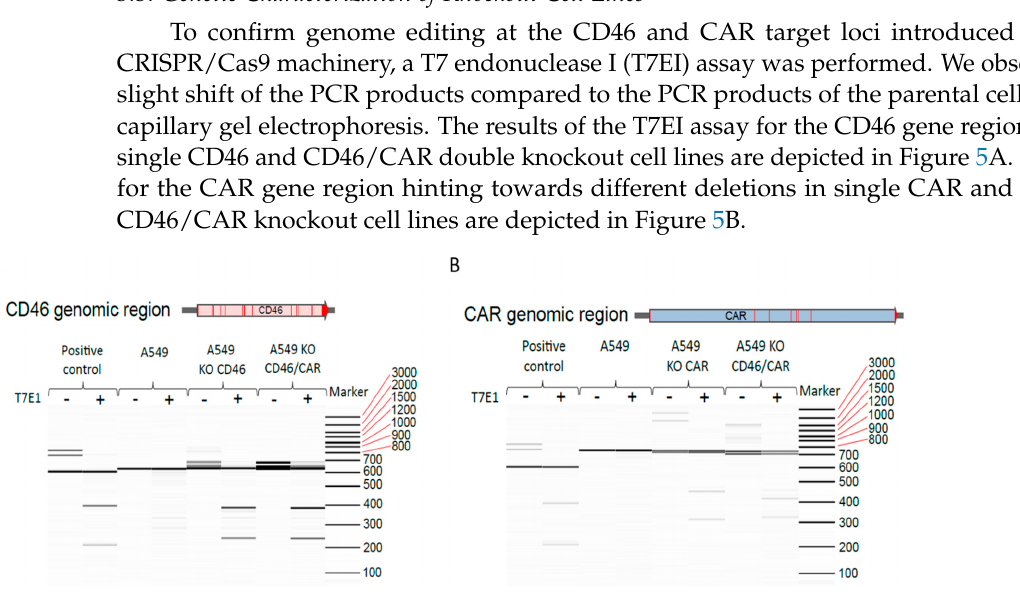
Figure 5. Analysis of the genome-edited CD46 and CAR loci in A549 cells. ( A ) To further confirm genome editing at the CD46 target locus, a T7 endonuclease I (T7EI) assay was performed. For this purpose, the genomic region of CD46 spanning the CRISPR/Cas target site was amplified by PCR and analyzed by the T7EI assay. Results are shown for the CD46 genomic region in A549, A549 KO CD46 and A549 KO CD46/CAR cells. Cleavage of the PCR product resulting in two smaller fragments indicates a CRISPR/Cas edit within the generated PCR product. The positive control was derived from the EnGen ® Mutation Detection Kit (New England Biolabs, MA, USA) and the PCR products were either T7EI-digested (+) or not ( − ). ( B ) To further confirm genome editing at the